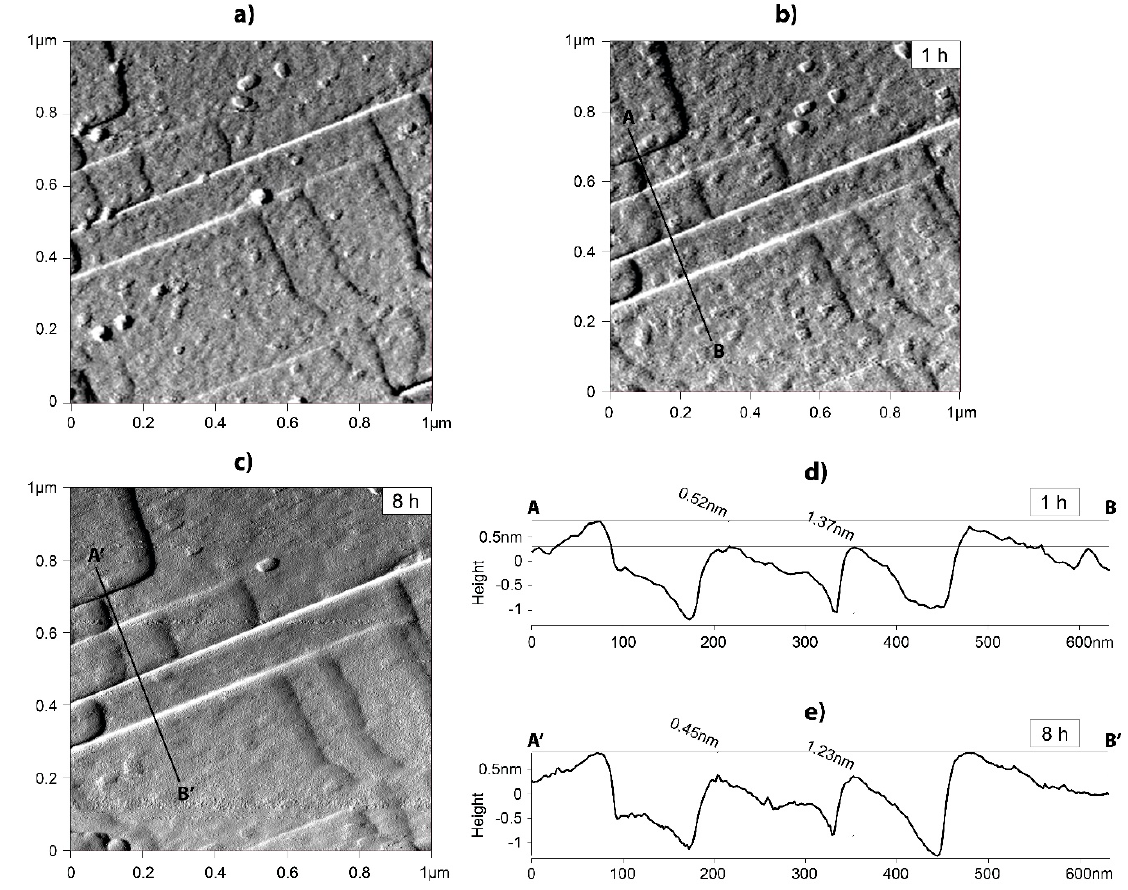
Figure 5. Sequence of amplitude retrace AFM images of the same surface area of FF surface at 37 °C ( a ) in water and at different time of interaction in ALF solution (pH 4.34): ( b ) 1 h; ( c ) 8 h. From the images and related sections ( d ) and ( e ) the surface dissolution and particles removal is notable.